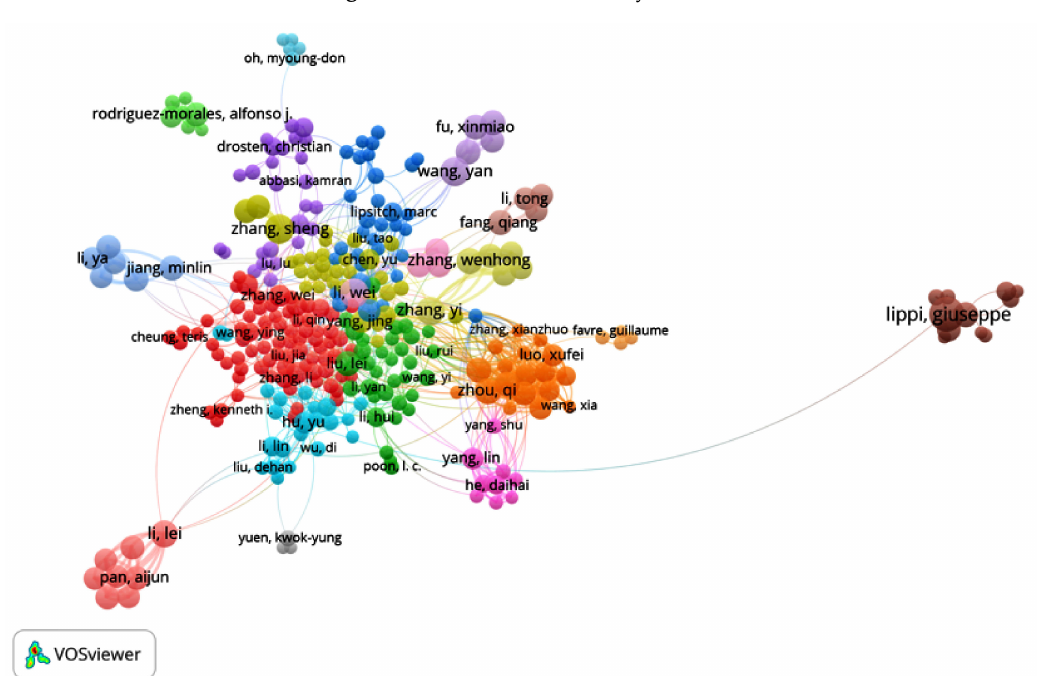
Figure 5. The most common keywords.